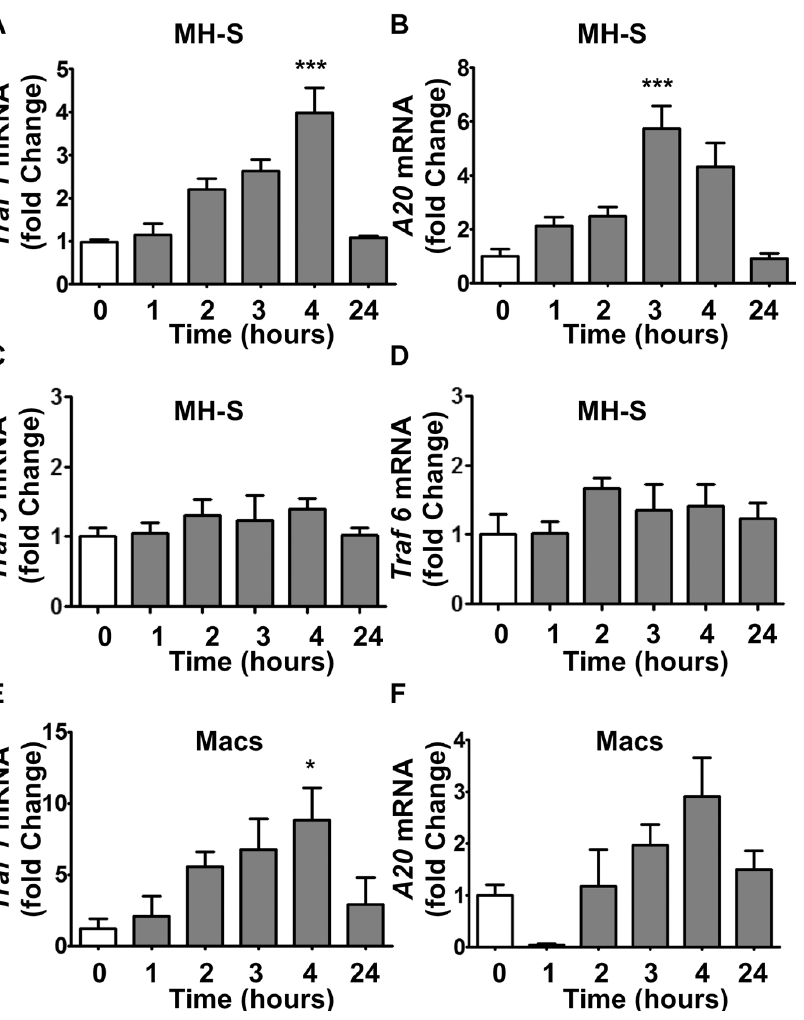
Figure 4. Oligo-HA induces inhibitors of TLR3 signaling via TLR4. MH-S cells (A, B, C, D) and peritoneal macrophages (Macs) from C57Bl/6J mice (E, F) were treated with 10 m g/ml oligo-HA or vehicle control for indicated time points. Traf1 , Traf3 , Traf6 and A20 mRNA expression was assessed by quantitative RT-PCR. Quantitative RT-PCR data are shown as relative expression compared to vehicle-treated macrophages. Data are means 6 S.E.M. and representative of three independent experiments with n=3. *: p , 0.05; ***: p , 0.001.